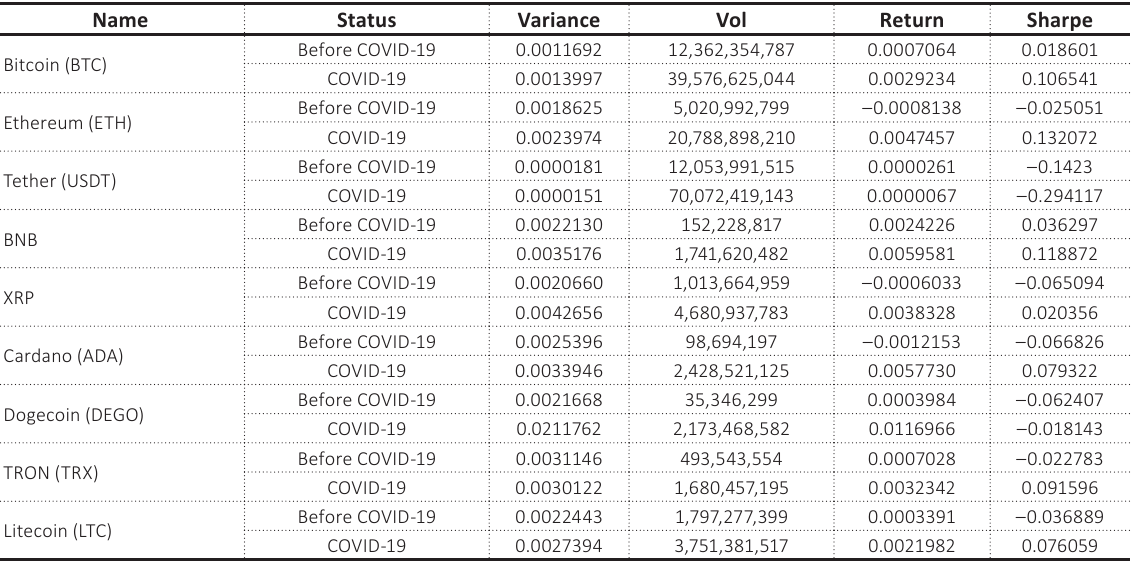
Table 2. Kruskal-Wallis, all Crypto